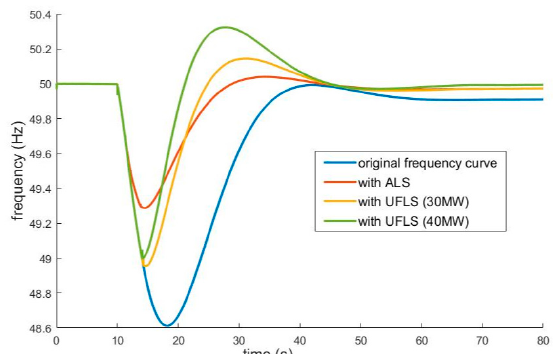
Figure 13. Comparison of control performances between under-frequency load shedding (UFLS) and ALS.